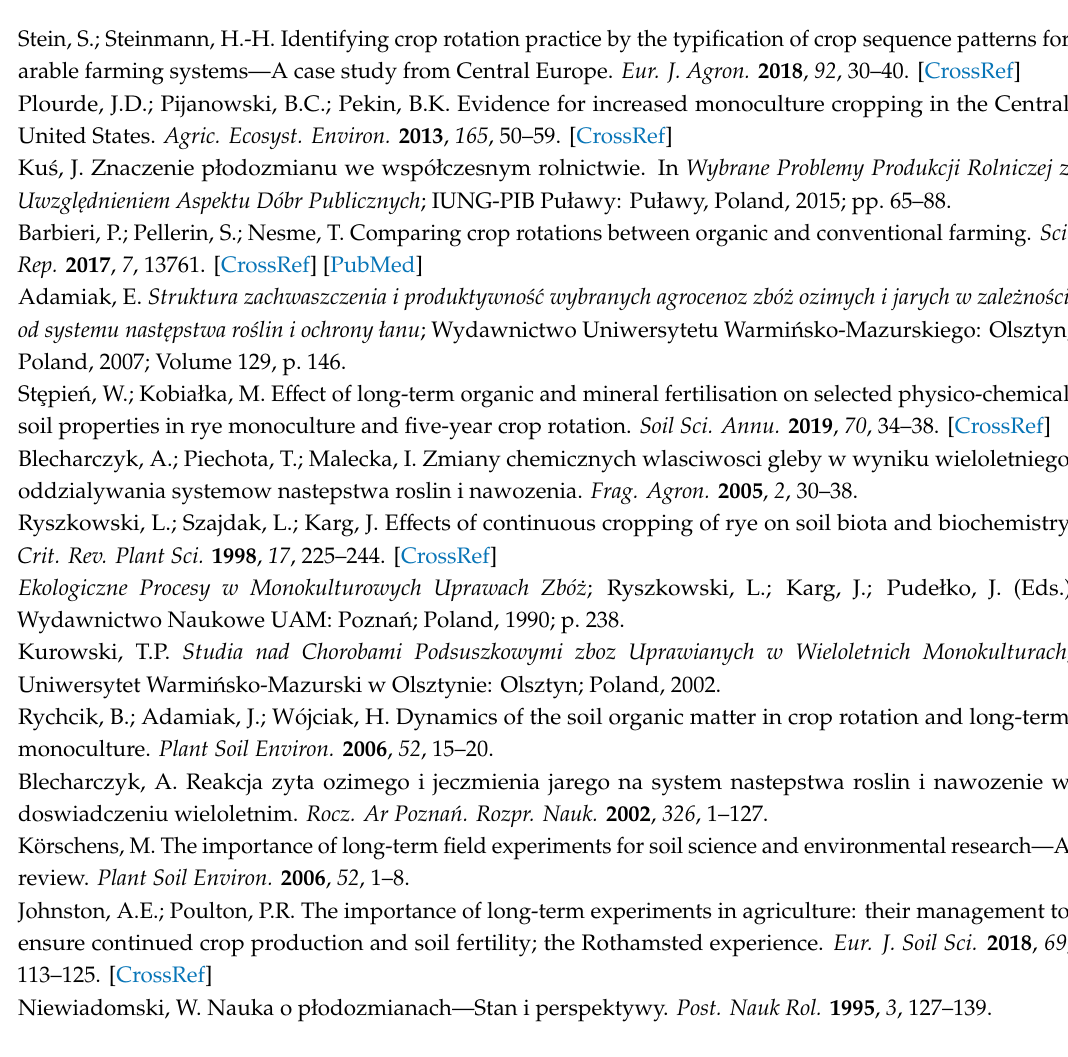
Table S1: Average proportion (%) of weed species biomass in the years